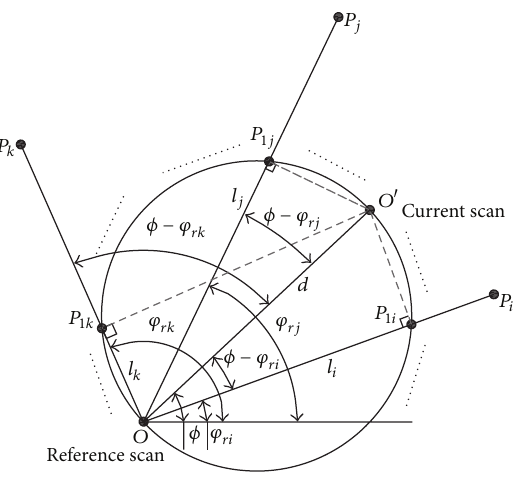
Figure 5: Projection circle.